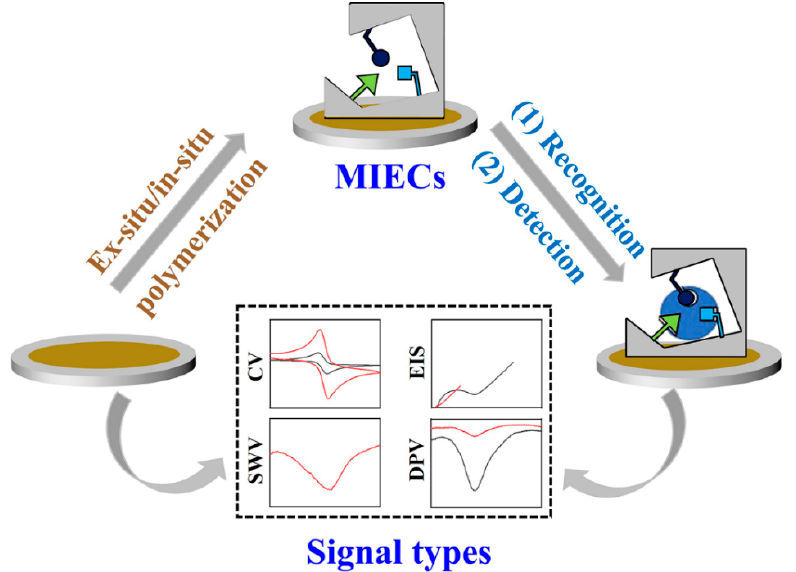
Figure 2. Illustration of working principle of MIECs from the preparation of MIPs to electrochemical signal output.